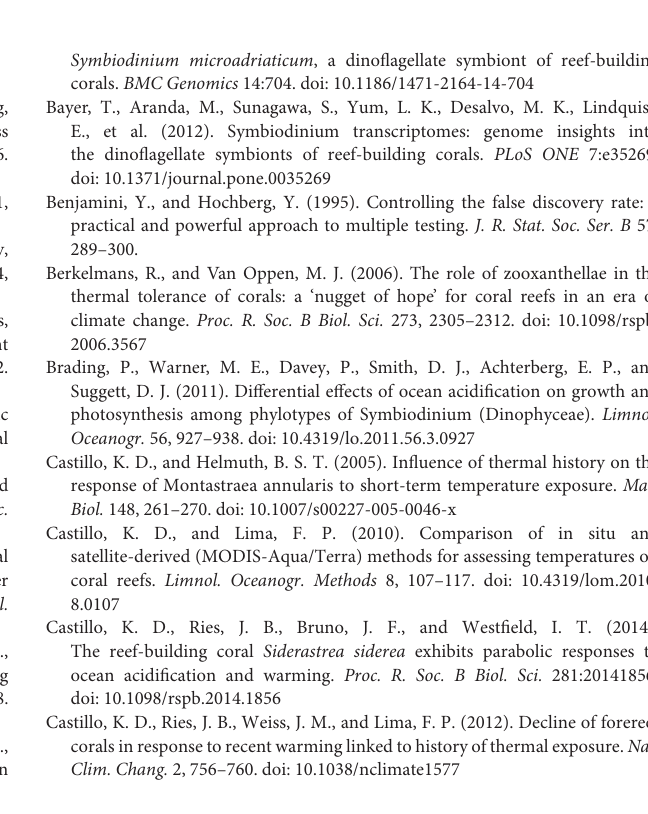
and thermal stress conditions. Blue circles: forereef population average ( ± SE); red triangles: nearshore population average ( ± SE). High temperatures reduce coral color intensity, however, symbionts from nearshore and forereef corals do not differ significantly within a treatment. Supplementary Figure 2 | Heatmaps for the expression of highly conserved genes (HCG) found to be differentially expressed in the coral host for each experimental treatment. The left four columns represent expression of these genes in the coral host (orange blocks) and the right four columns represent expression of these same genes in Symbiodinium goreaui (green blocks) across the experimental treatments relative to the control (28.16 ± 0.24 ◦ C, 477 ± 83 µ atm): (A) low temperature (T25 = 25.01 ± 0.14 ◦ C, 515 ± 92 µ atm), (B) pre-industrial p CO